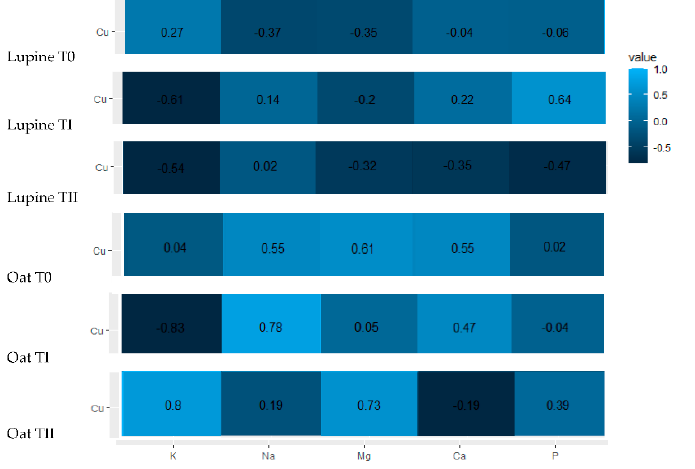
Figure 5. The effect of treating the soil with two amendments on mean Ca, K, Mg, Na and P amounts in oat grown on soils: T0—control soil, TI—soil with compost addition and TII—soil with FA addi- tion. In the figure, the letters denote homogenous groups.